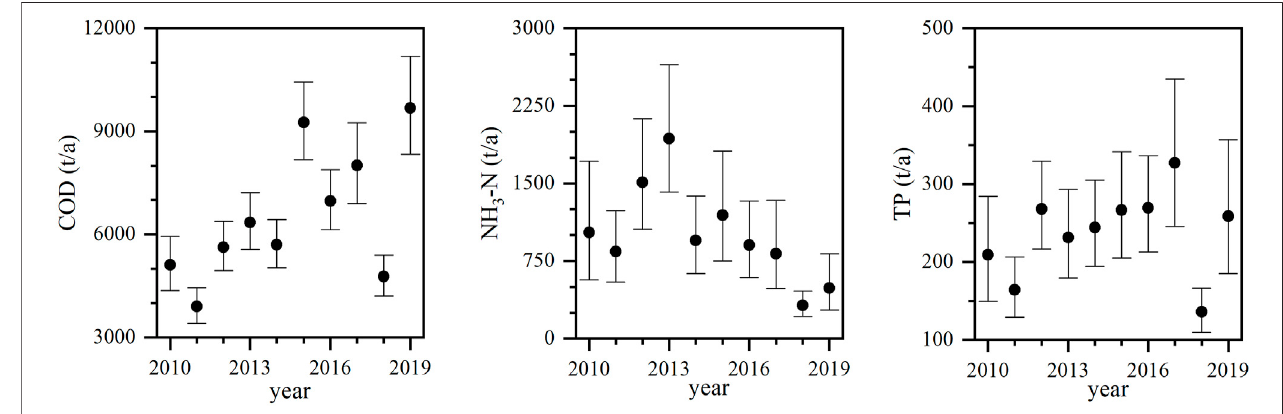
FIGURE 3 | Estimated annual fl uxes of COD, NH 3 -N, and TP from 2010 to 2019. (Symbols represent annual fl uxes; lines represent 95% con fi dence intervals).